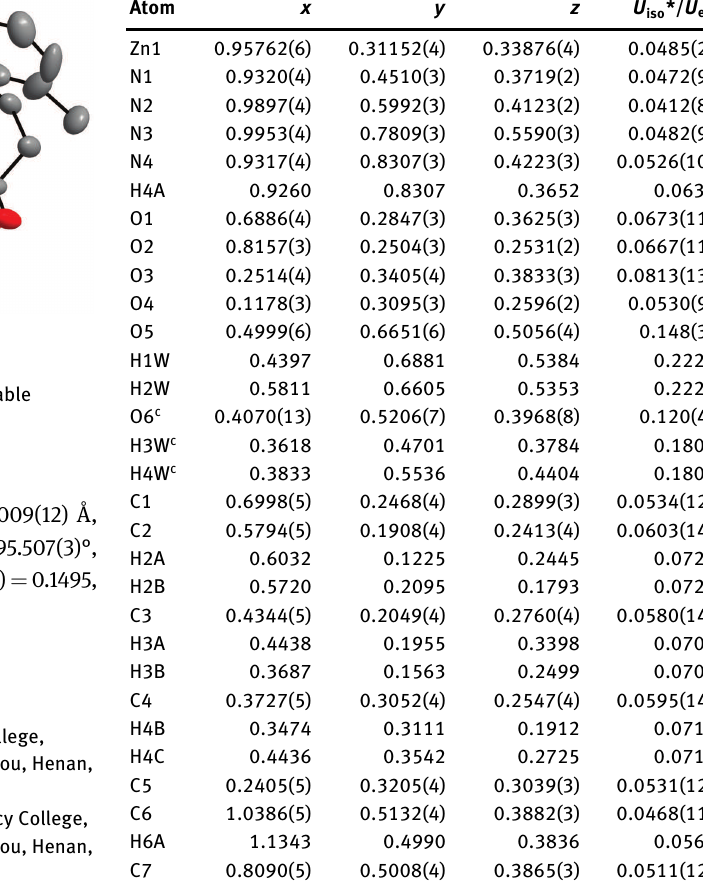
Table 2: Fractional atomic coordinates and isotropic or equivalent isotropic displacement parameters (Å 2